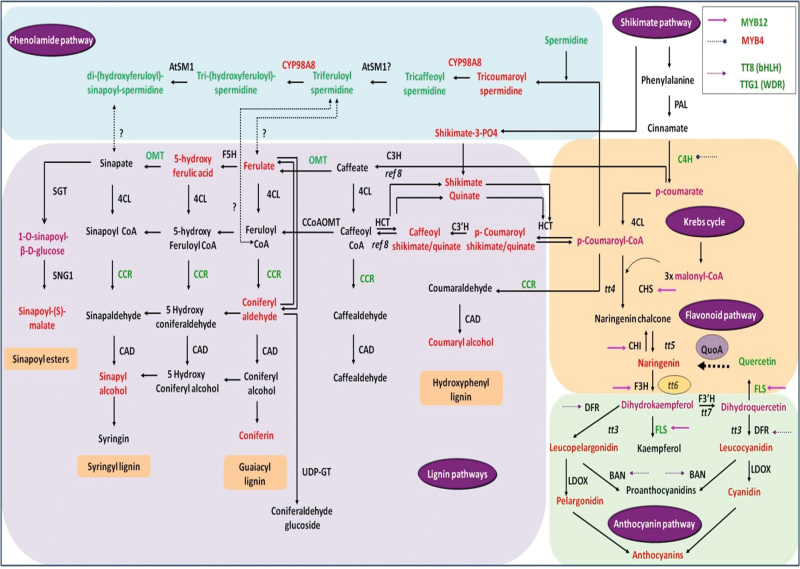
Summary of perturbational effect metabolite and gene expression perturbation resulting from QuoA expression. The metabolites that showed overaccumulation and genes that were overexpressed in QuoA transgenic plant Q10 are indicated in red, while those that were downregulated are shown in green. The coloured arrows indicate the target genes of the regulators that showed differential expression in this study. The key for regulators is shown in the inset box. The point of perturbation is boxed in light orange. Only metabolic pathways belonging to Arabidopsis are shown (based on TAIR, http://www.arabidopsis.org/, 10 September 2013; Matsuno et al., 2009; Umezawa, 2009). See Fig. 1 legend for abbreviations. The fold changes are represented as: >2, red; < 2, green; <1.3, purple. All metabolites/genes represented in black fonts did not show changes.